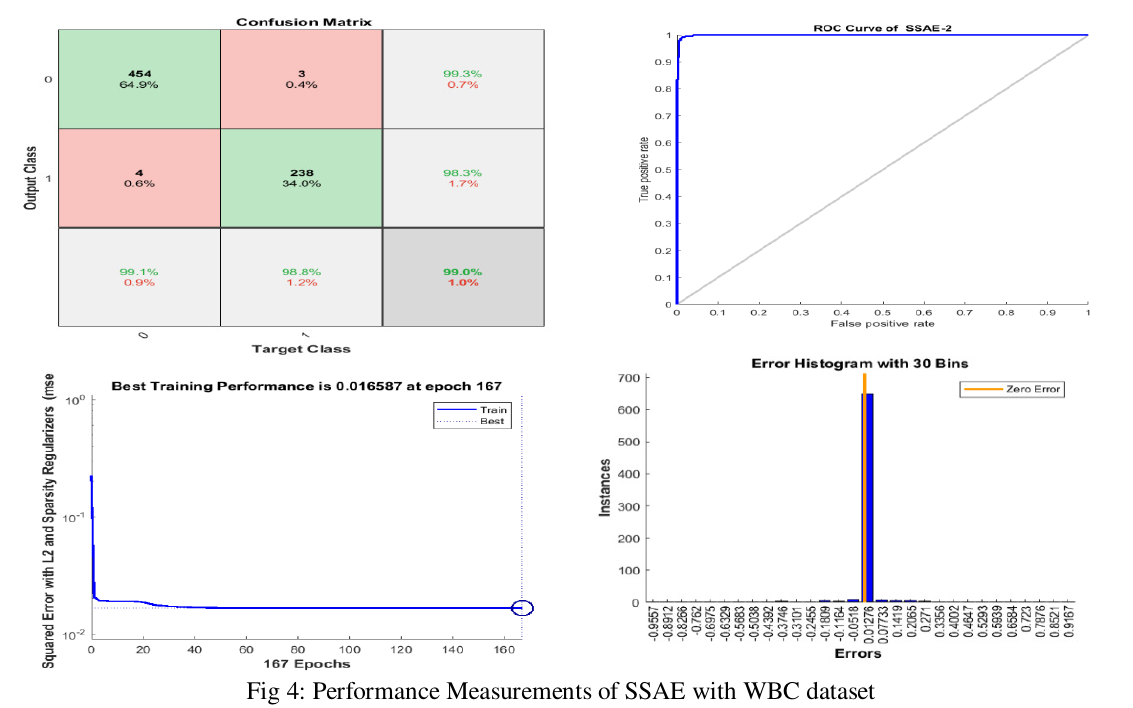
Fig 4: Performance Measurements of SSAE with WBC